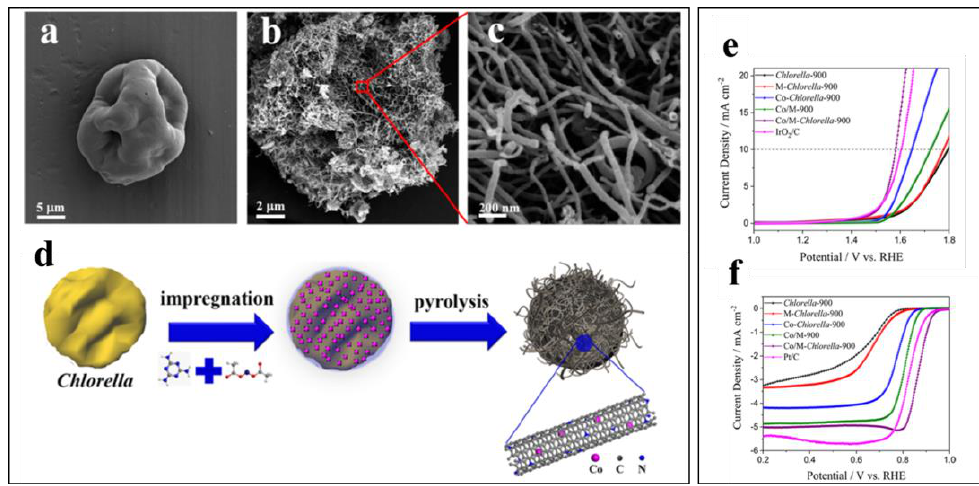
Figure 4. ( a ) SEM image of Chlorella algae and ( b ), ( c ) SEM images of Co/M-Chlorella-900. ( d ) schematic illustration of the preparation process of Co/M-Chlorella-900. ( e ) LSV curves for five catalysts from Chlorella algae and 20 wt % commercial Pt/C in 0.1 M KOH solution. ( f ) LSV curves for five catalysts from Chlorella algae and commercial IrO 2 /C in 0.1 M KOH solution. Reproduced from [77] with permission of the American Chemical Society 2020.